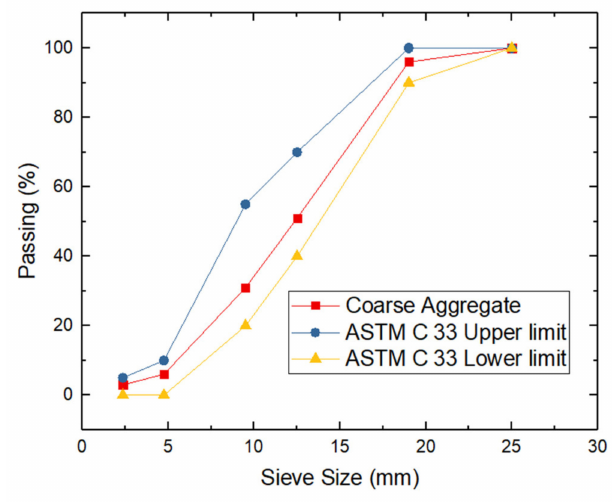
Figure 1. Grading curve of the coarse aggregate.